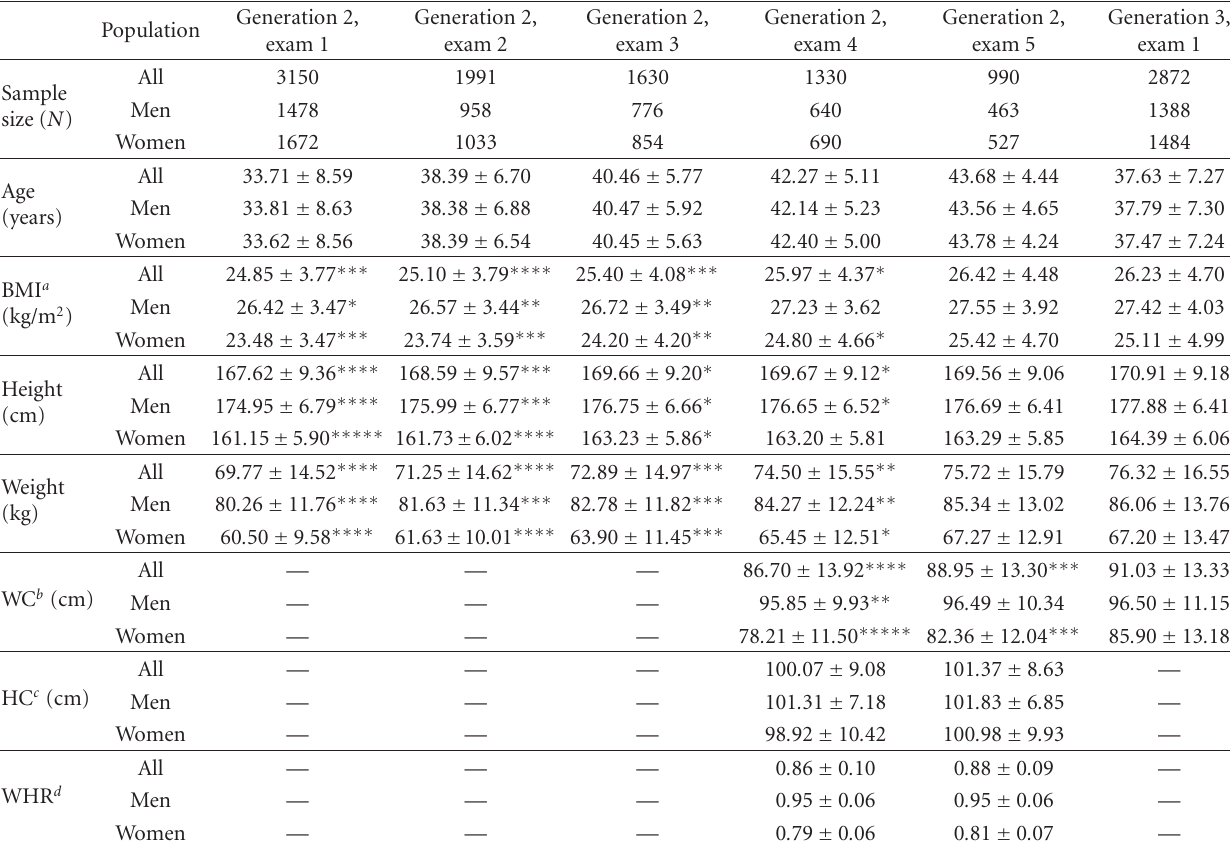
Table 1: Mean ± standard deviation for obesity-related traits in Framingham subjects < 50 years